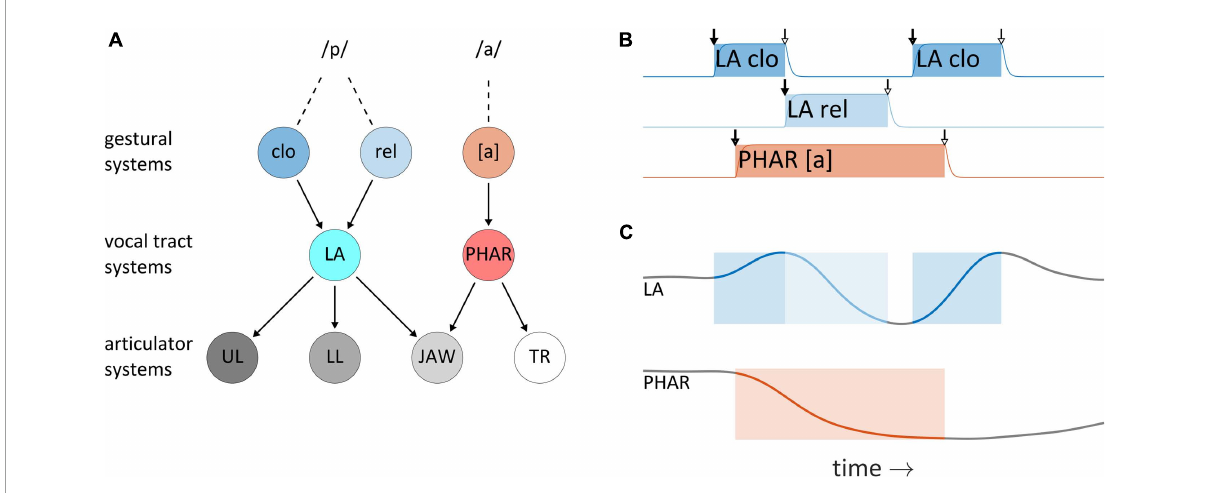
FIGURE3 System organization and interactions in the Task Dynamics model. (A) Organization of system interactions (see text for descriptions of systems). (B) Gestural activation intervals for the CVC syllable pop. (C) Vocal tract geometry changes resulting from the actions of gestural systems on vocal tract systems. Lip aperture (LA) and pharyngeal constriction (PHAR) timeseries are